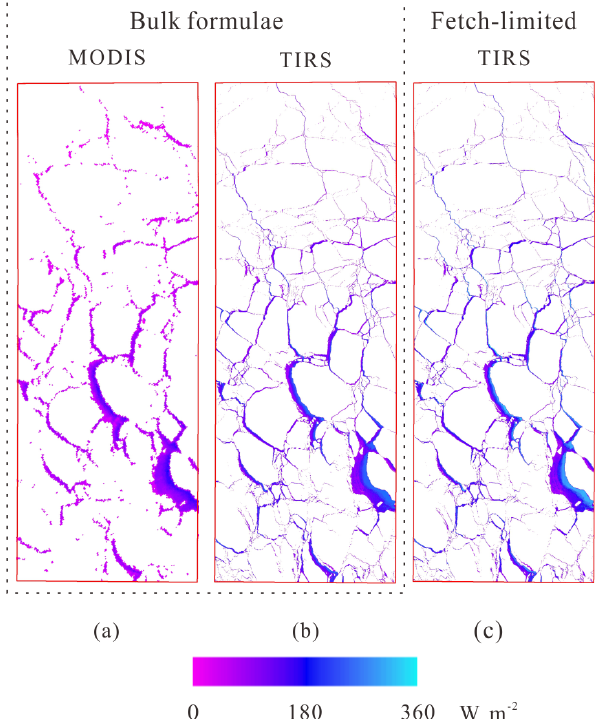
Figure 11. Spatial distribution of heat flux derived from MODIS and Landsat-8 using bulk formulae and a fetch-limited model. (a) Turbulent heat flux from MODIS using bulk formulae, (b) turbu- lent heat flux from Landsat-8 TIRS using bulk formulae, and (c) tur- bulent heat flux from Landsat-8 TIRS using a fetch-limited model.